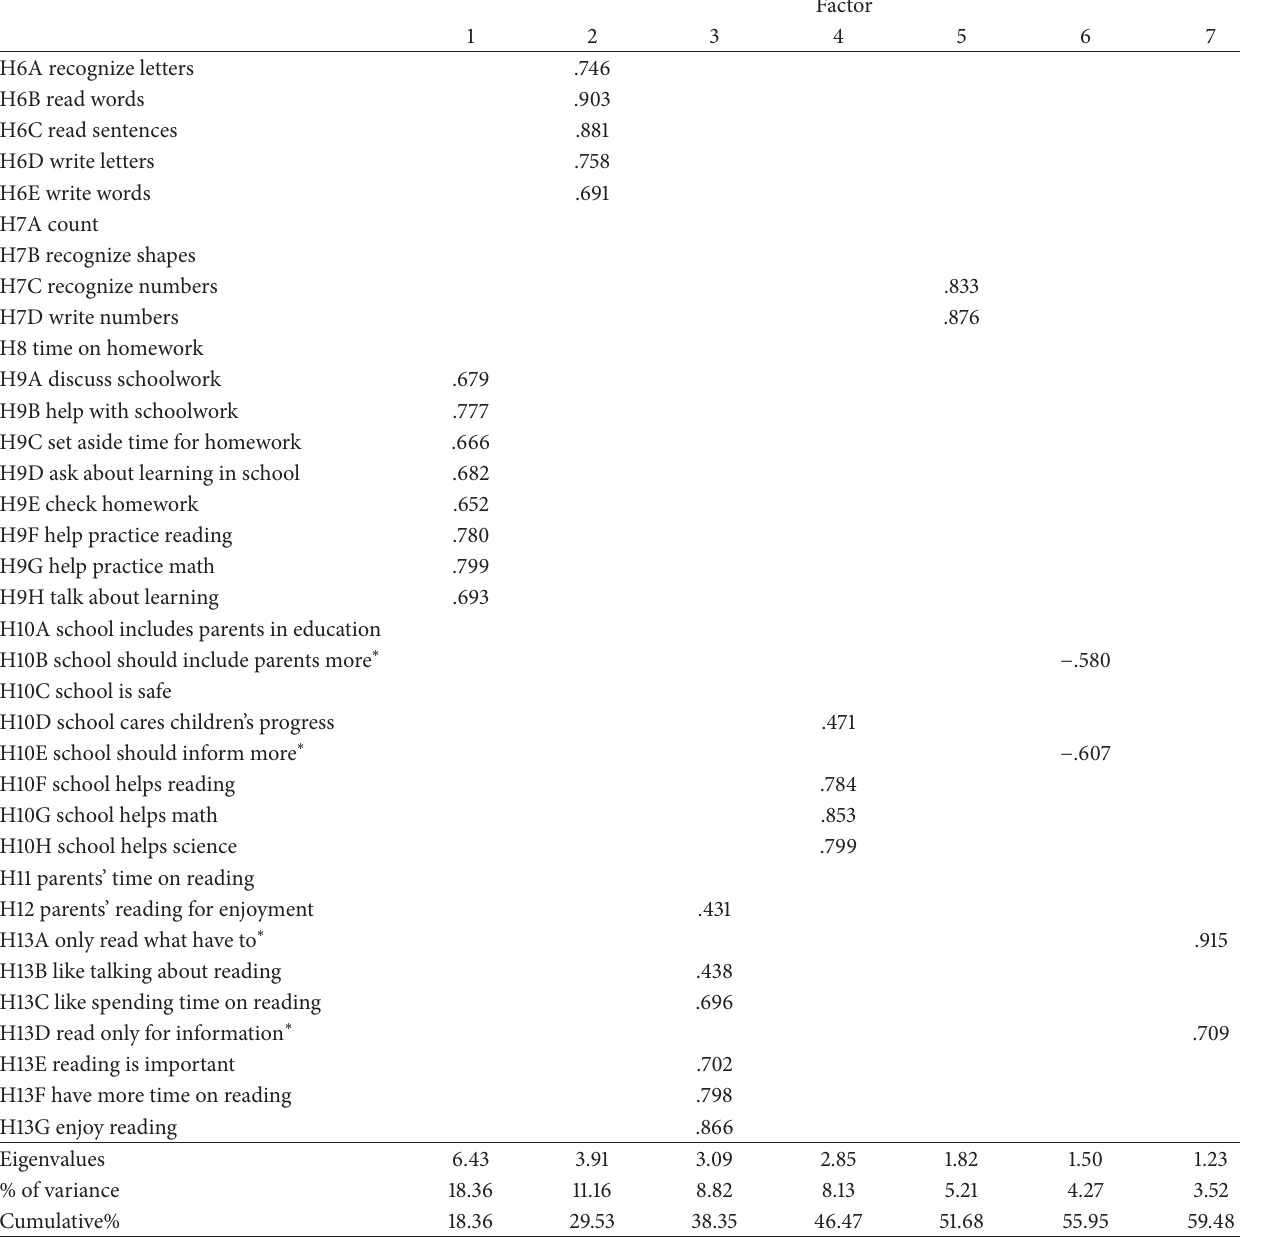
Table 2: Exploratory factor analysis for the PIRLS 2011 home questionnaire (PIRLS-HQCV